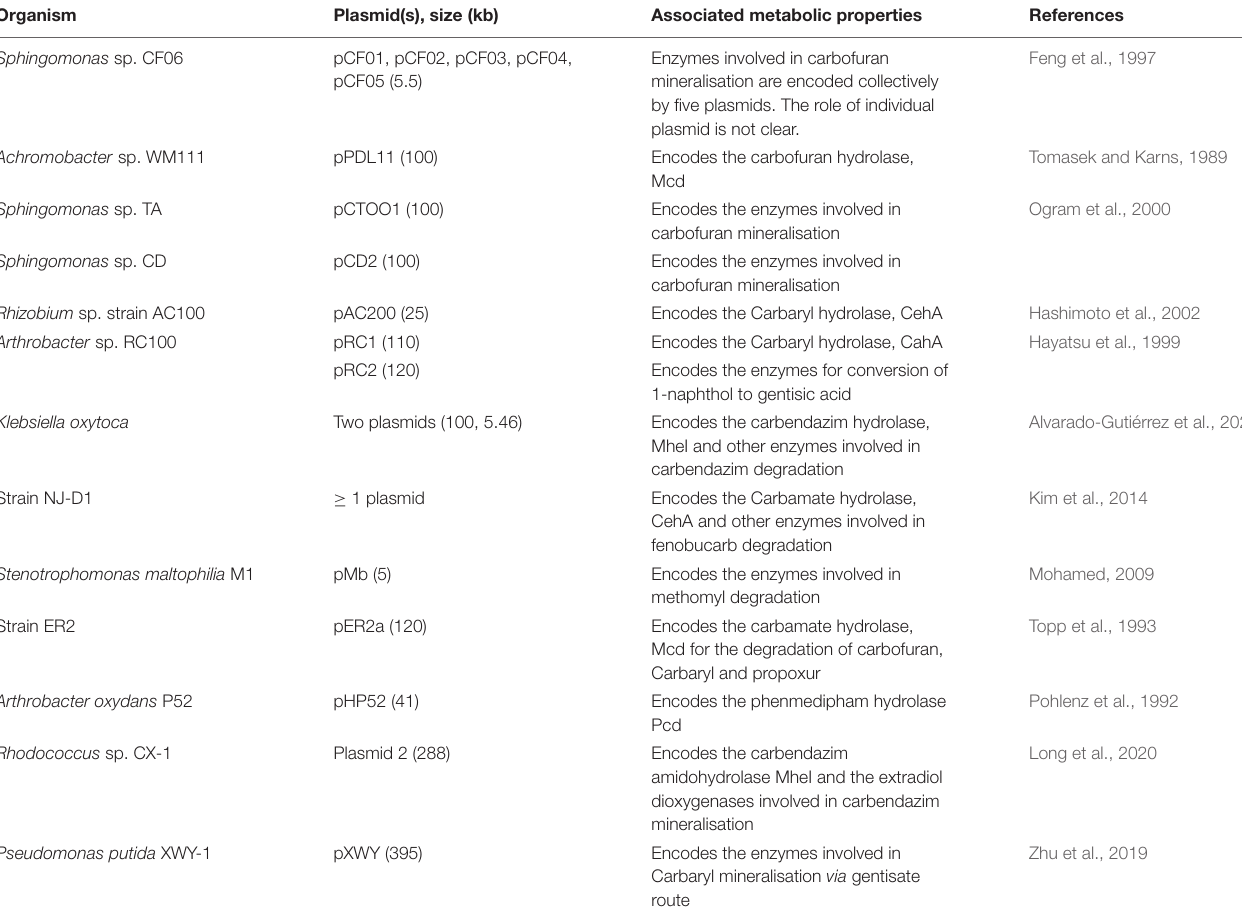
TABLE 2 | Plasmids involved in the degradation of carbamate